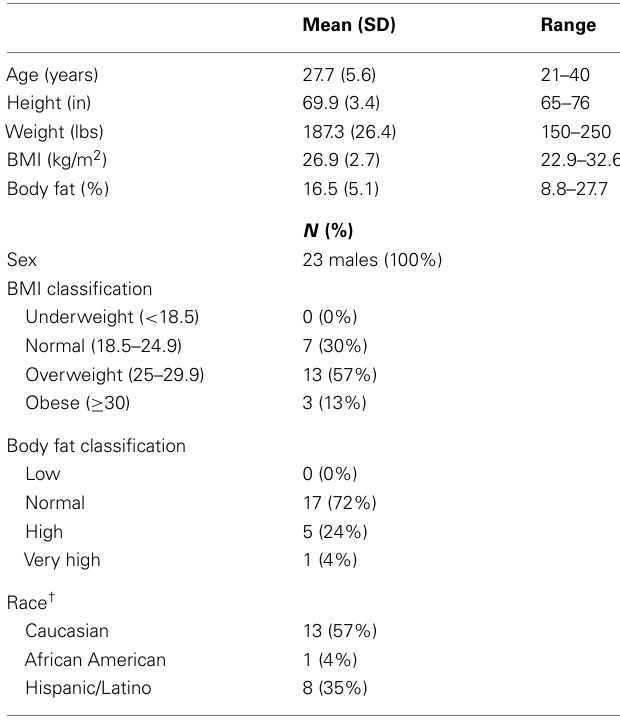
Table 1 | Demographics and participant characteristics ( N =